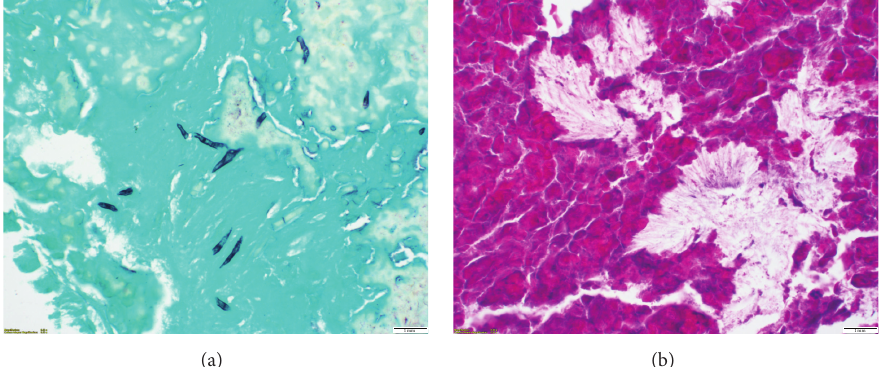
Figure 3: (a) GMS stain demonstrating scattered noninvasive fungal hyphae. (b) H&E stain showing allergic mucin and lamellated inflammatory debris with numerous eosinophils and Charcot-Leyden